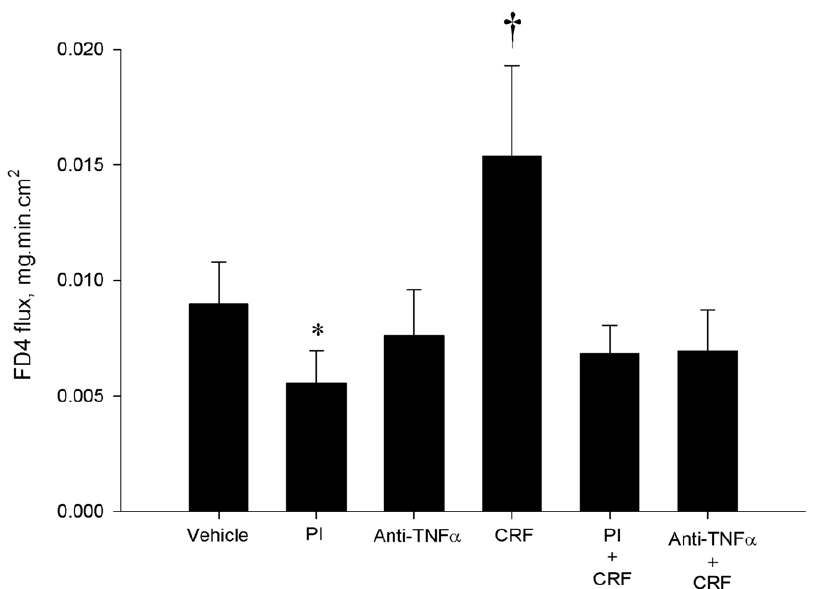
Figure 7. Neutralization of TNF- a and protease activity inhibits CRF-induced increases in FD4 flux in porcine ileum. Pretreatment of porcine ileum mounted on Ussing chambers with neutralizing anti-TNF- a antibody prevented CRF –induced increased in FD4 flux. Pre-treatment of porcine ileum with a protease inhibitor (PI) cocktail reduced baseline FD4 flux values and CRF-induced increases in FD4 flux. Values represent means SE; n= 6 2 8 animals. Symbols (*, { ) differ from other treatments by p , 0.05.